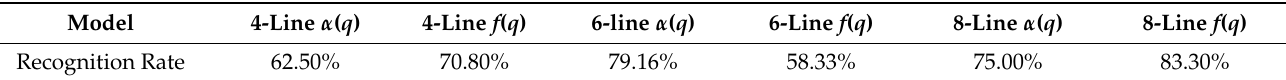
Table 3. The image is cut horizontally at a certain step to enhance the data; test set recognition rate after data